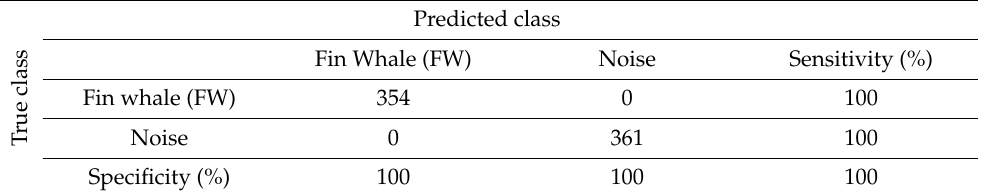
Table 3. The confusion matrix for the proposed method with the ‘Fin whale (FW) + Noise’ dataset (the accuracy (%) is indicated in bold font and calculated as a ratio of the sum of diagonal values to the sum of all values × 100).